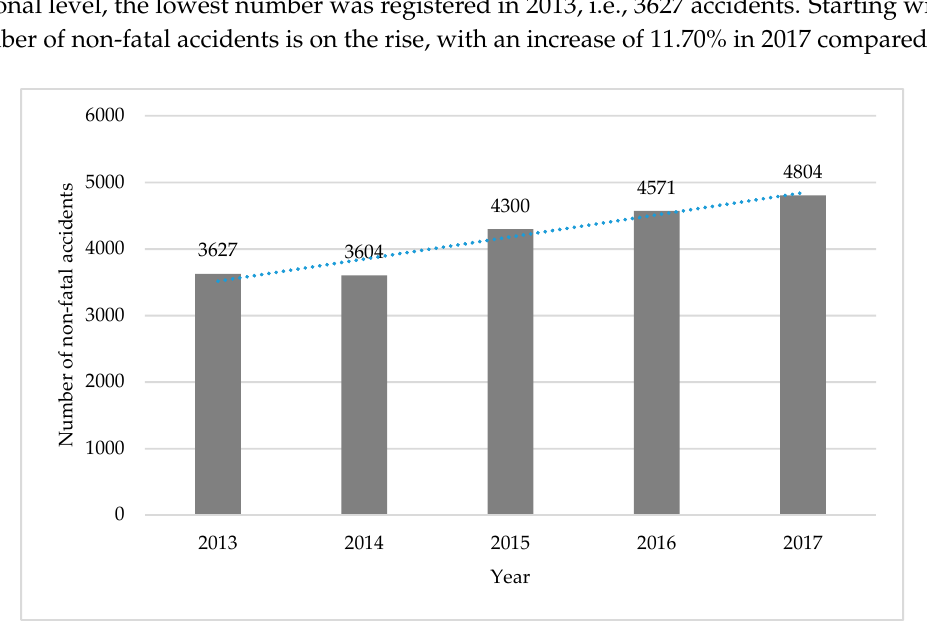
Figure 7. Number of employees in Romania in 2013–2017 [2].